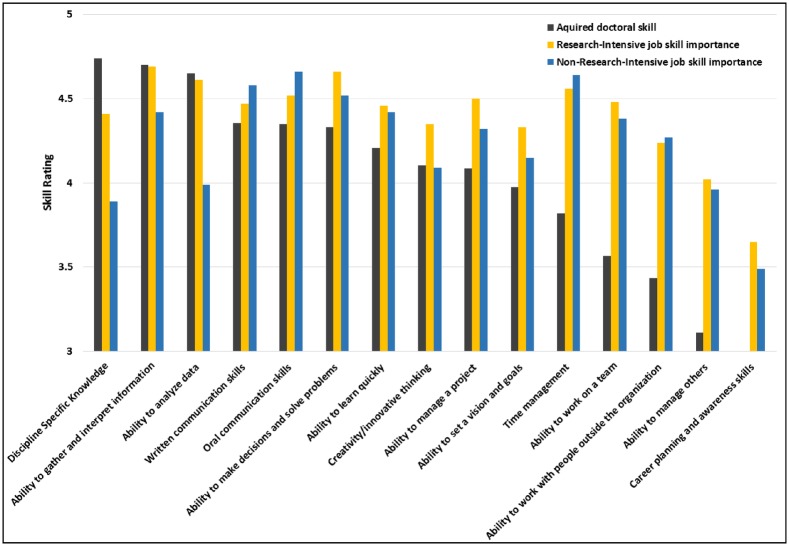
Transferrable skills: Acquired doctoral skills and skill importance ratings in research-intensive and non-research-intensive careers (means).Fig 1 Skills ordered from left (highest) to right (lowest) using transferrable skill ratings acquired during doctoral training as the reference category.